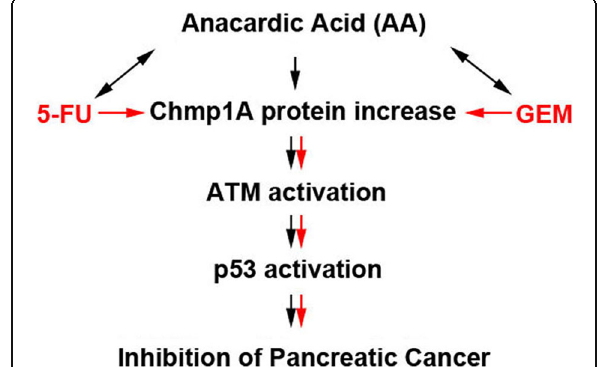
Fig. 6 Schematic diagram showing the working hypothesis of Anacardic Acid. As shown in the diagram, AA inhibits pancreatic cancer growth by the increase of Chmp1A protein, which leads to phosphorylation of ATM, an indication of activation. Phospho- ATM then induces activation of p53 via phosphorylation of p53 (shown in short black arrows). 5- FU or GEM may utilize the similar signaling pathway as AA for its anticancer action, increasing Chmp1A protein to activation of ATM and p53 (shown in short red arrows). Subsequently, AA synergizes with 5-FU or GEM (indicated as double headed black arrows), and increases the activation of signaling pathway and cancer cell grwoth inhibition (shown as black and red arrows together). Black arrows indicate signaling activities for both sufficient and necessary action, and red for sufficient action